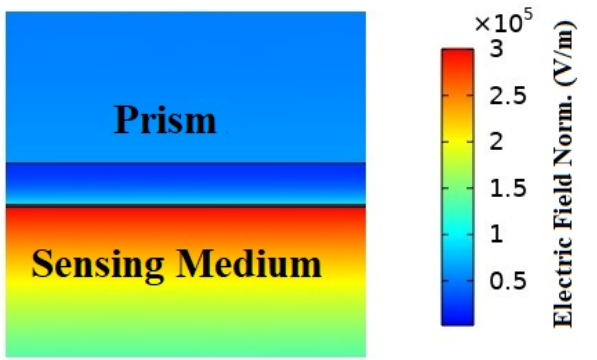
Figure 2. COMSOL Multiphysics design layout for the proposed (BK7/ Ag/ MoS 2 / MXene) SPR biosensor: ( a ) The field of computational meshing; ( b ) A simulation-based model for the pro- posed structure.